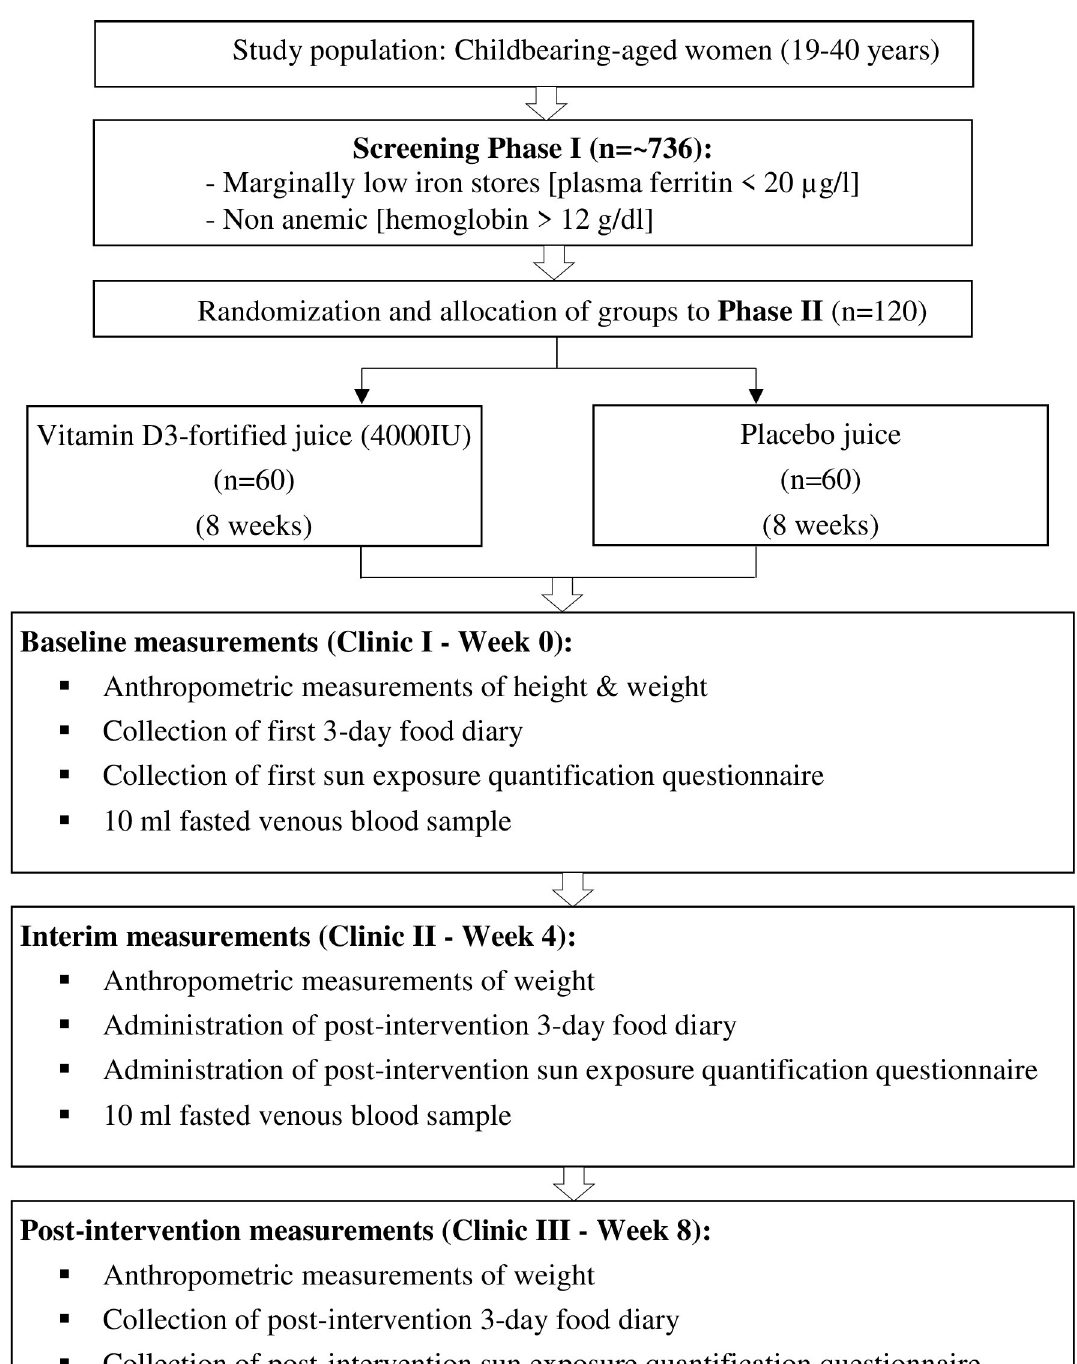
Clinic 2 (Week 4, interim): The same procedure will be repeated except for height measure- ment. Participants will be given a 3-day food diary to be completed before the next clinic.